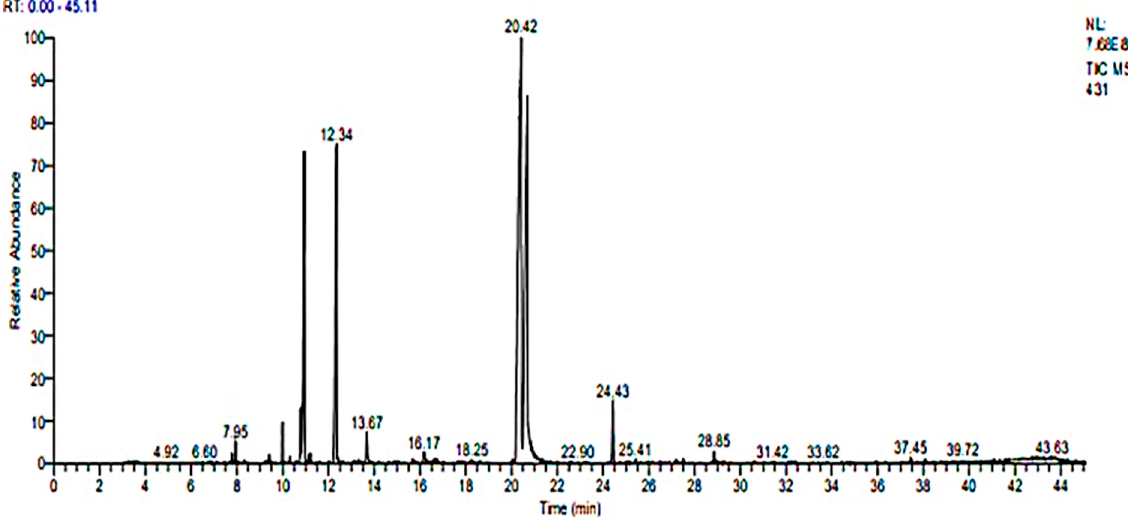
Figure 1. Chromatographic profiles of GC/MS analysis of the O. campactum EO sample